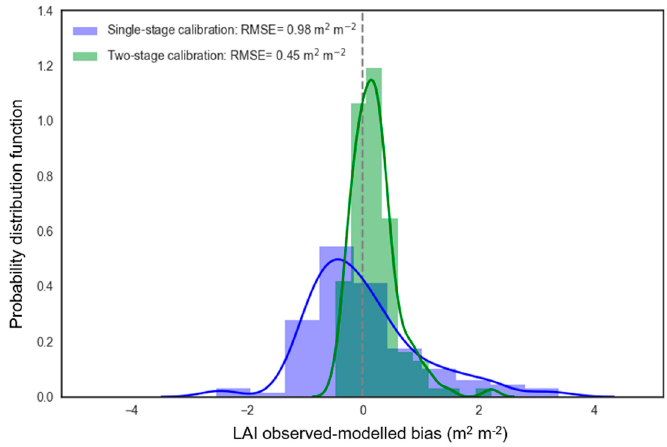
Figure 7. Comparison of observed–modelled LAI bias probability distribution function plots for the single-stage (blue line and shading) and two-stage (green line and shading) calibration approaches.